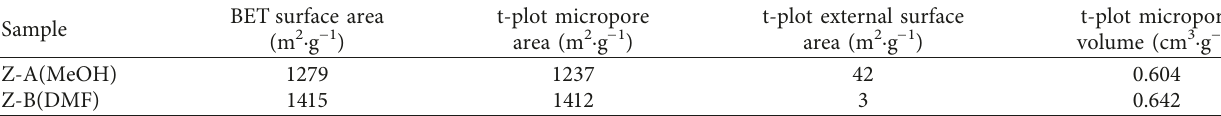
Table 2: Characteristics of ZIF-8 obtained in different solvents. Product (state, color, and abundance ratio) Solvent Process A Process